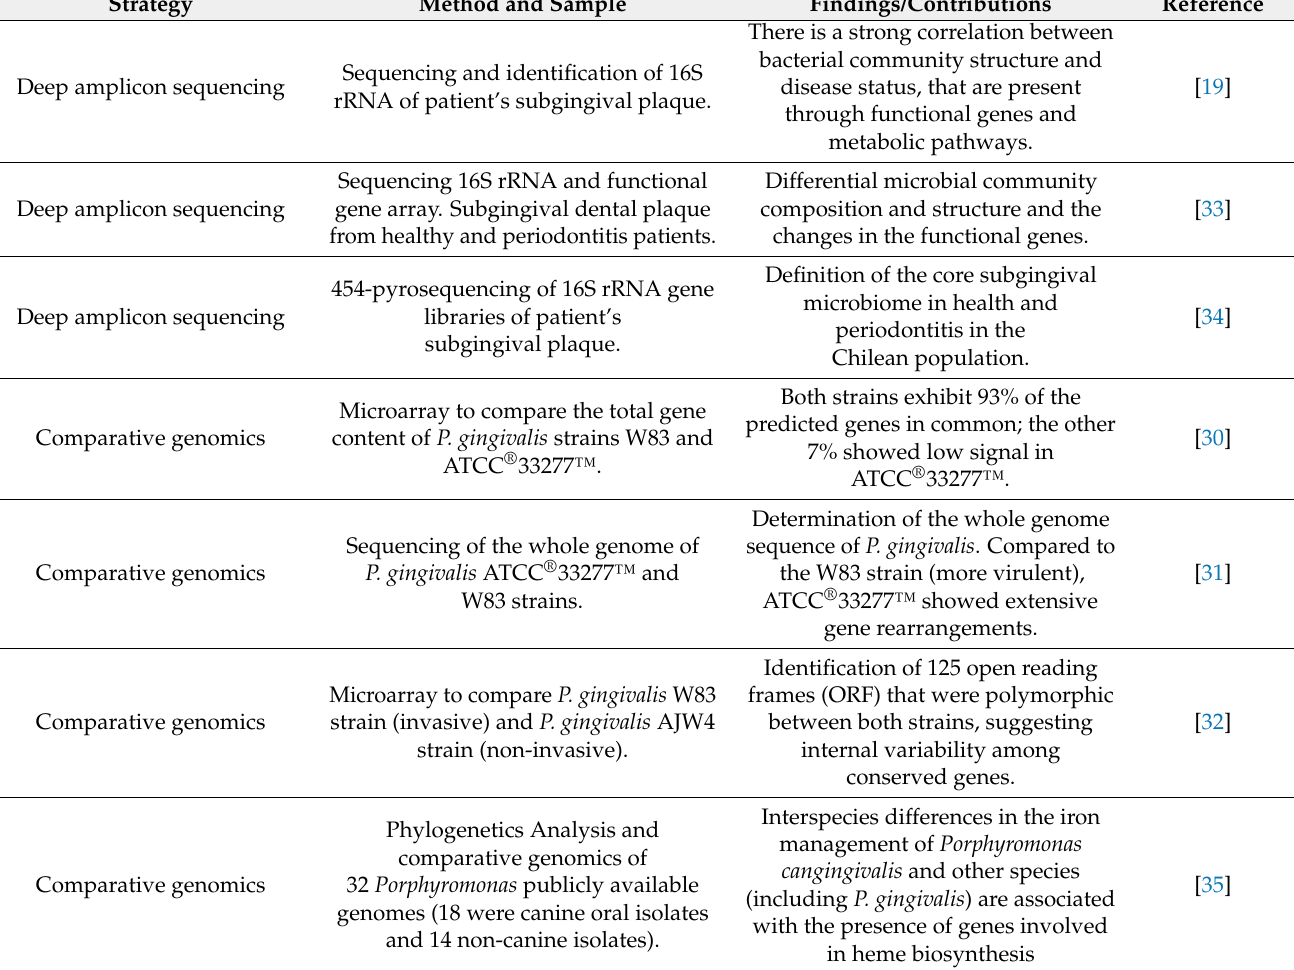
Table 1. Summary of deep amplicon sequencing, comparative genomics and metagenomics research studies associated to this